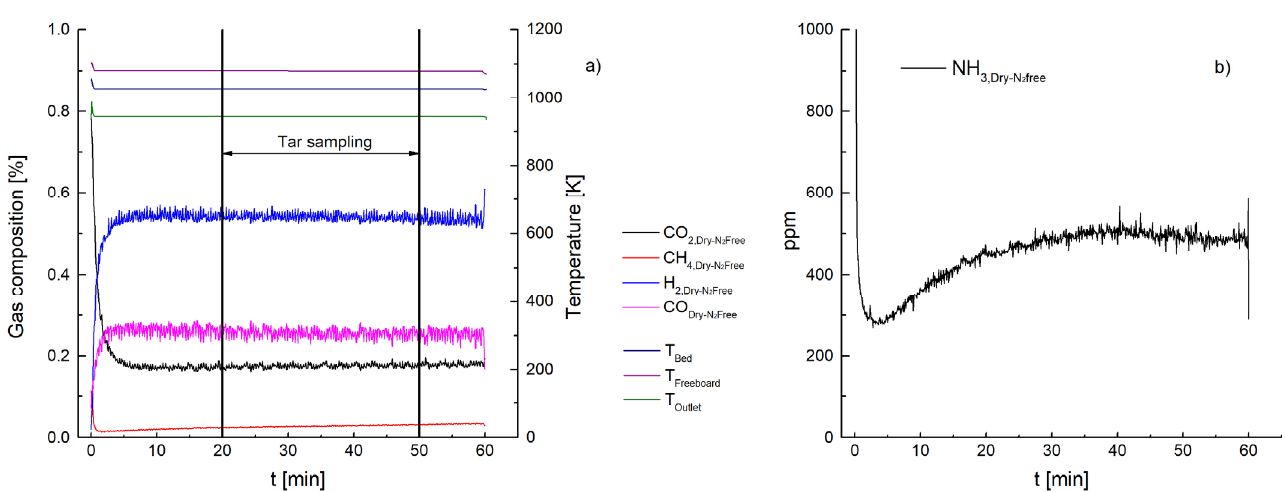
Figure A1. Temperature and gas composition ( a ) and ammonia content ( b ) during test 1.